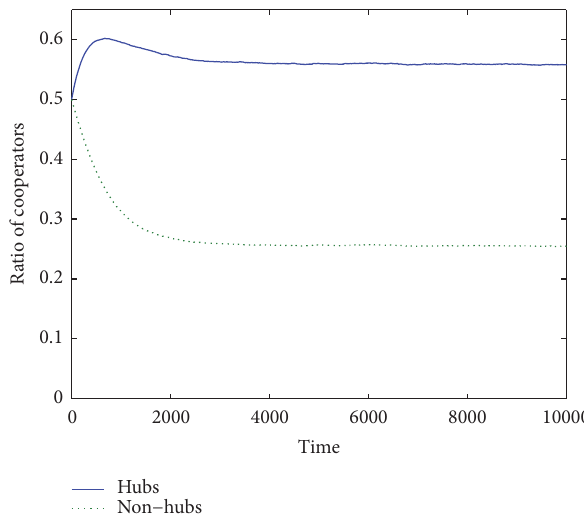
Figure 8: Time evolution of the mean ratio of the cooperators according to the types of nodes. More than half of the people at the hubs remain cooperative, while over two-thirds of the people at nonhubs quickly turn selfish. The results are obtained from 100,000 times of Monte Carlo simulations with 𝛼 = 3